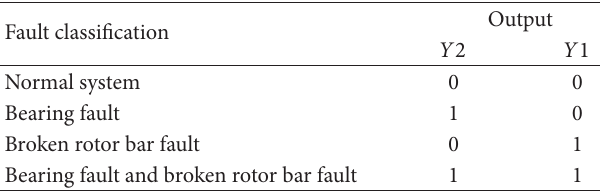
Table 2: The network fault model and the corresponding output